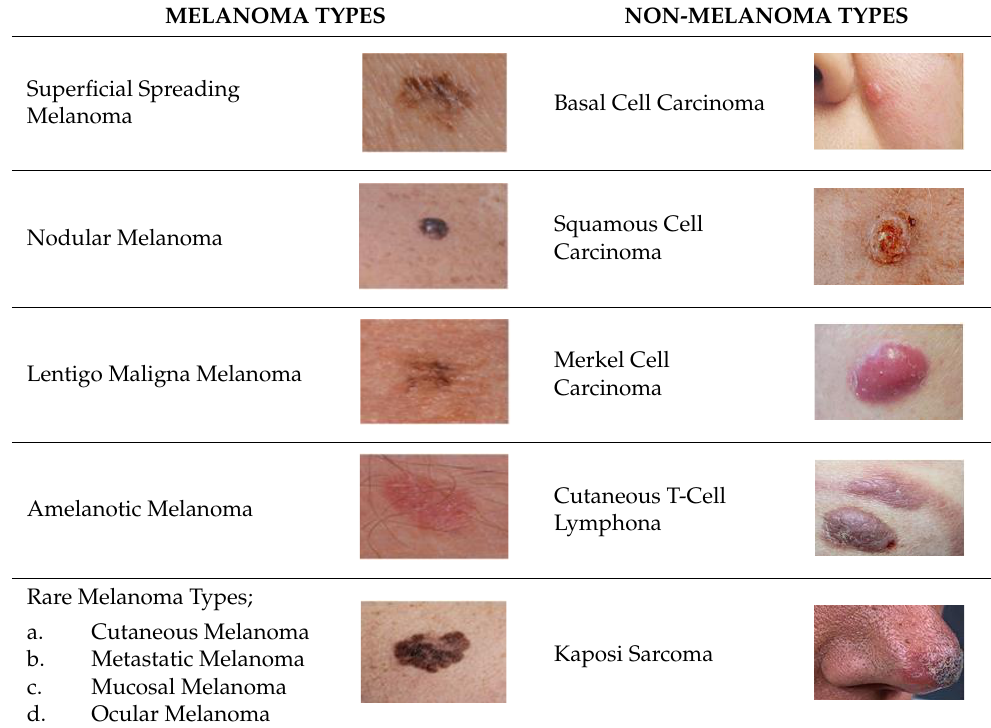
Table 1. Different Types of melanoma and non-melanoma [10 – 14].